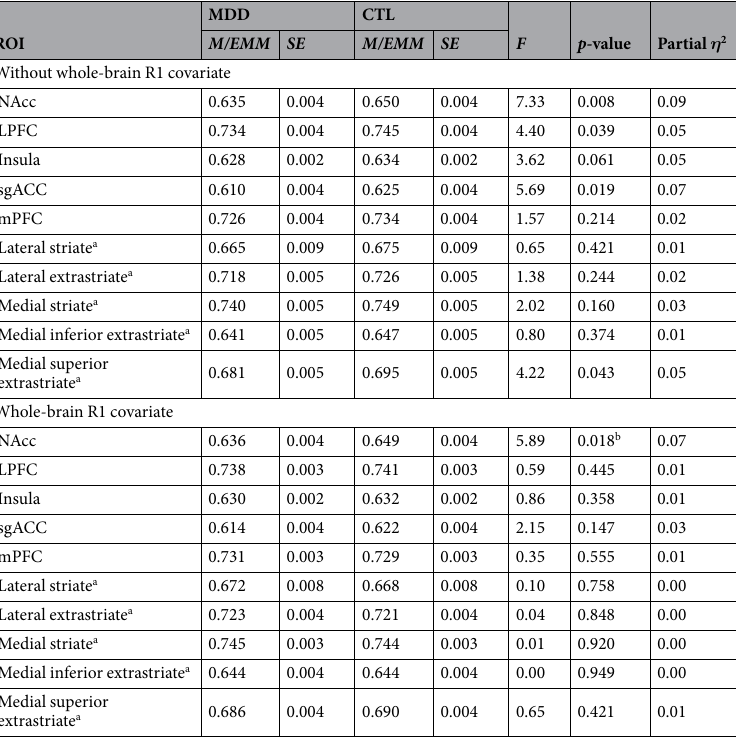
Table 2. Regional assessment of R1. General linear models repeated over hemisphere were used to assess the effect of group in regional R1. MDD = Major Depressive Disorder group; CTL = healthy control group; R = right; L = left; ROI = region of interest; M / EMM = mean or estimated marginal mean, EEM computed when covarying for whole-brain R1; SE = standard error; F = general linear model F -statistic for the effect of group; LPFC = lateral prefrontal cortex; sgACC = subgenual anterior cingulate cortex; mPFC = medial prefrontal cortex; a = visual network control regions; b = when including the whole-brain R1 covariate only the NAcc exhibited a significant effect of group.